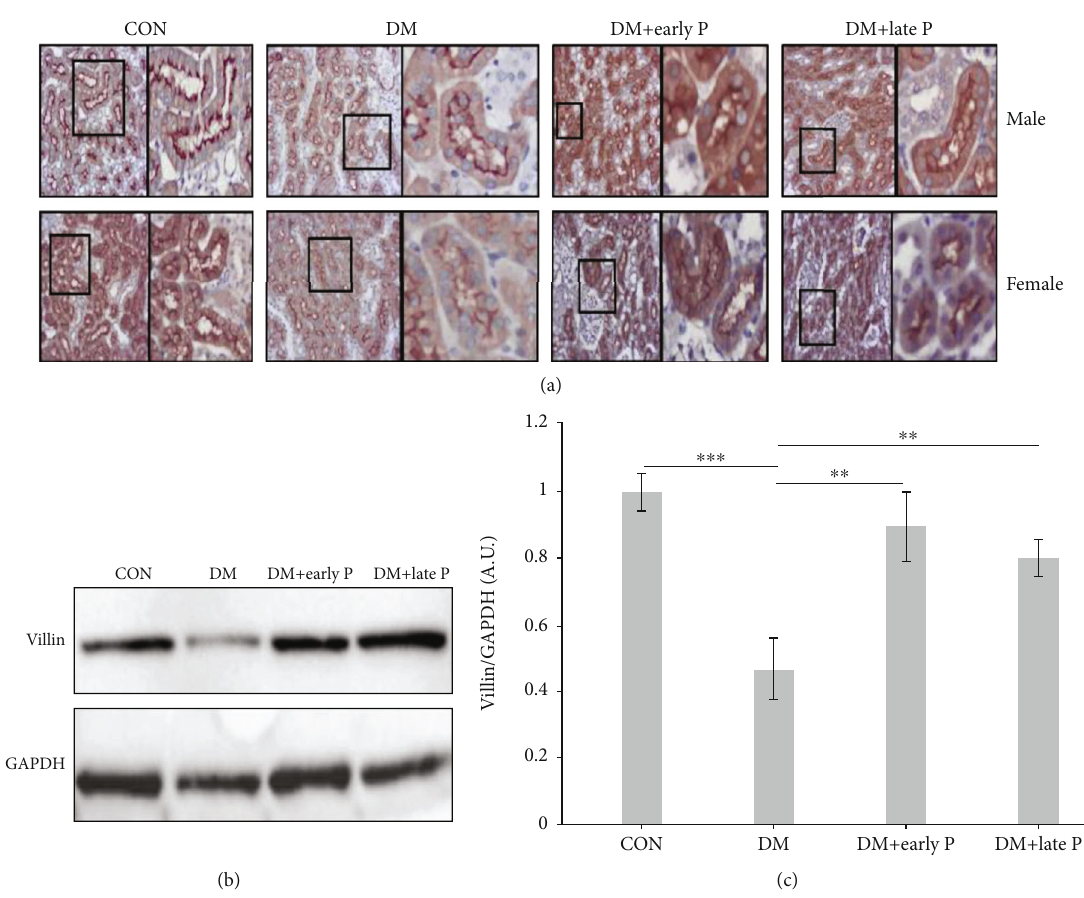
Figure 4: Fibronectin expression in mouse renal tissues. (a) Immunohistochemical analysis of fi bronectin expression in diabetes mellitus (DM) mouse kidney sections. Sections of DM mice exhibited high expression of fi bronectin as compared to control (CON) sections. Paricalcitol treatment (DM+early P, DM+late P) decreased fi bronectin expression. Magni fi cation, × 20. (b) Representative western blots of fi bronectin and GAPDH proteins extracted from mouse renal tissues. (c) Quanti fi cation of total western blots. Renal fi bronectin levels were signi fi cantly increased in DM mice ( n = 10 ) compared with control mice ( n = 11 ) ( ∗∗∗ p < 0 : 001 ). A signi fi cant decrease in fi bronectin levels was observed in paricalcitol-treated mice (DM+early P ( n = 10 ), DM+late P ð n = 9 Þ treatments) compared with DM mice ( ∗∗∗ p < 0 : 001 ). Error bars correspond to SEM.